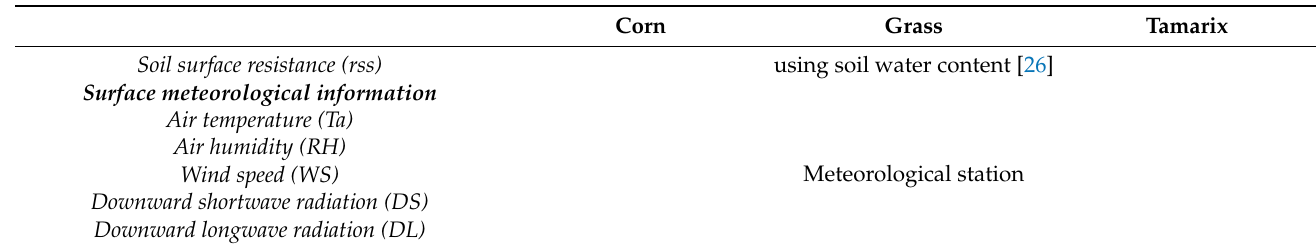
Table 2. Cont. Corn Grass Tamarix using soil water content